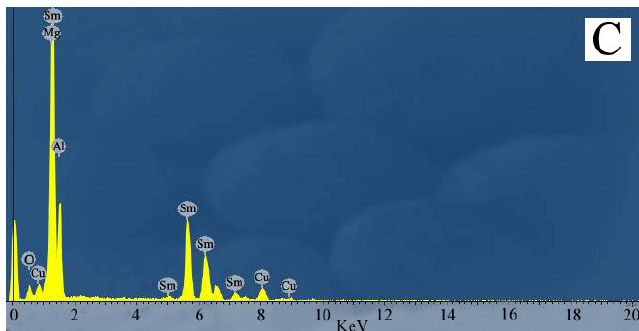
Figure 5. TEM image of ultrasonic-treated AZ91–xSm (x = 0, 0.5, 1.0, 1.5 wt %) magnesium alloys; ( a , b ) Al 2 Sm particle; ( c ) EDX results.